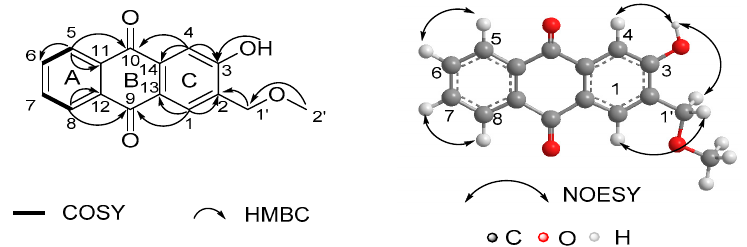
Figure 2. 1 H- 1 H COSY, key HMBC and NOESY correlations of compound 1 .